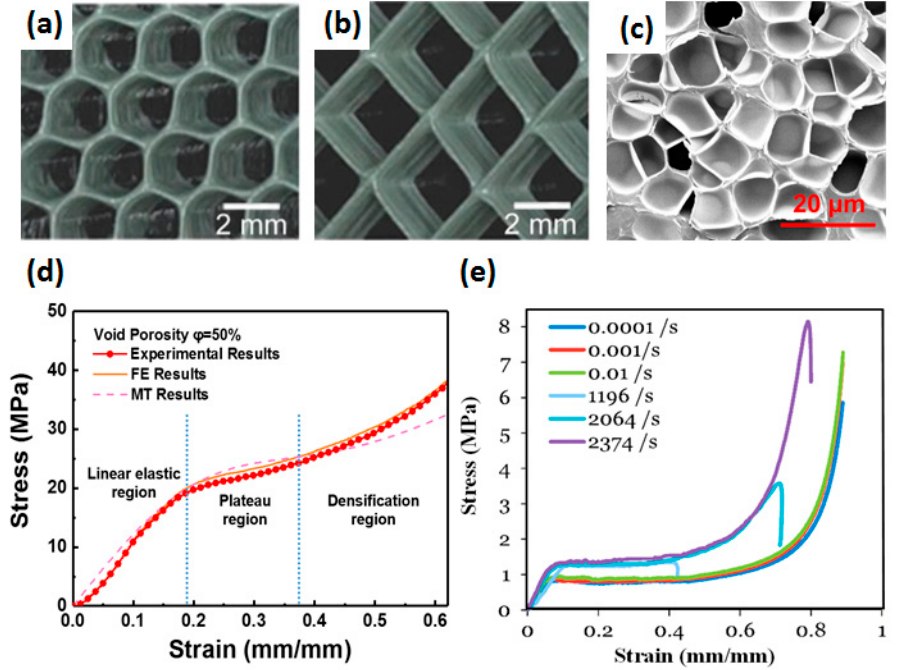
Figure 2. Artificial cellular medium ( a ) square honeycomb structure, ( b ) hexagonal honeycomb [2,29], ( c ) foaming materials [30], and stress-strain curves of cellular medium under ( d ) quasi-static compression [30] and ( e ) dynamic compression [31].